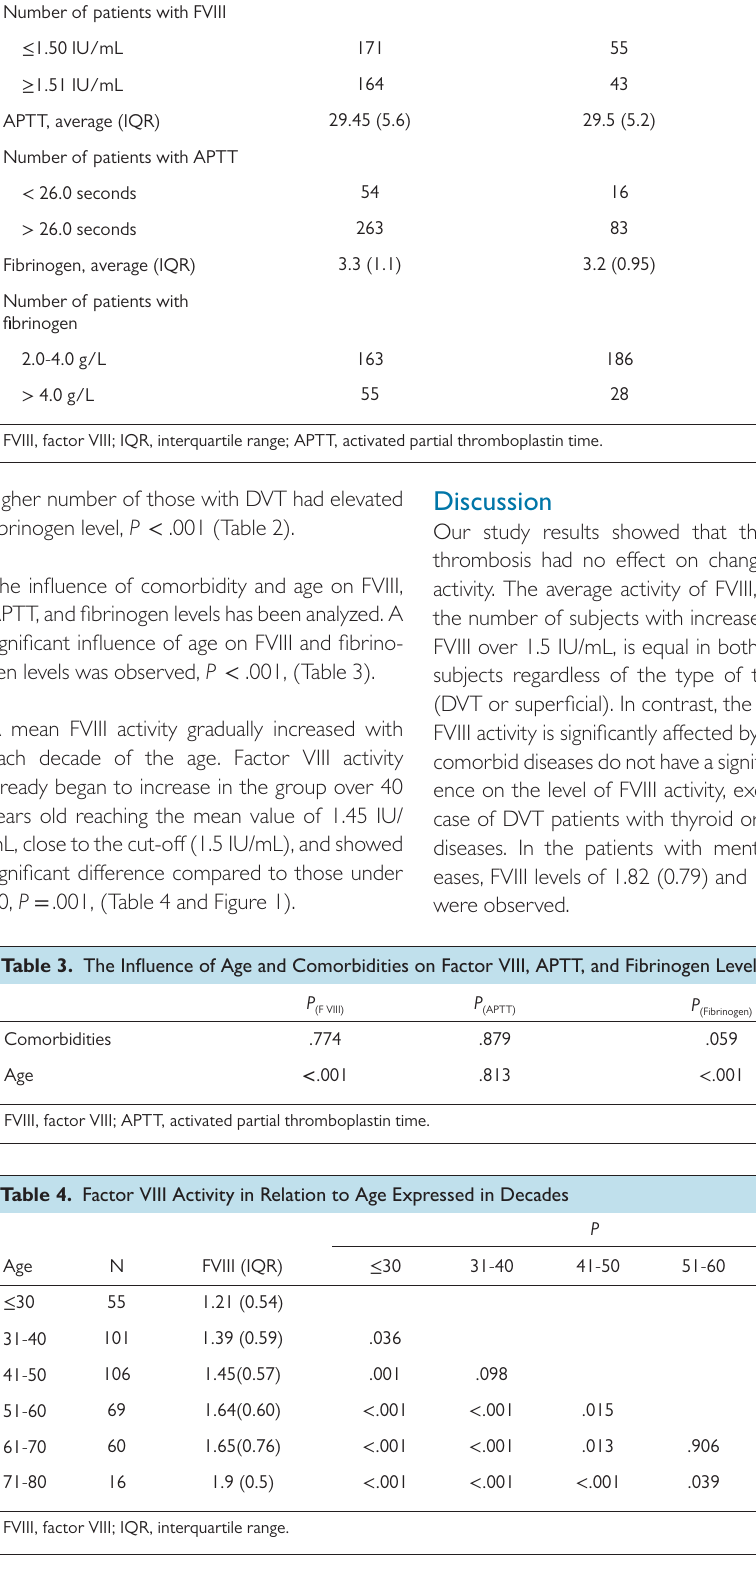
Table 2. Factor VIII Activity, APTT, and Fibrinogen Level in Relation to Thrombosis Type